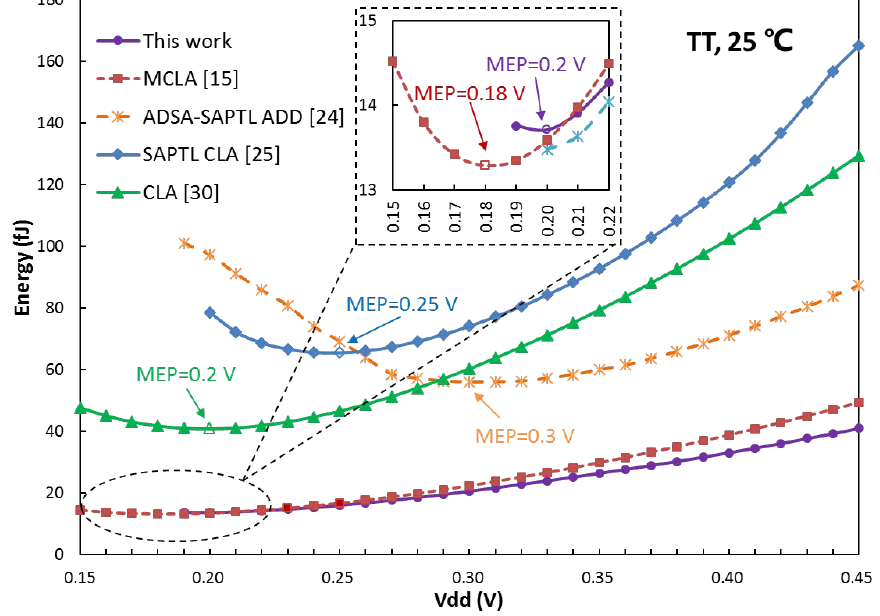
Figure 9. The energy consumption per operation versus V dd